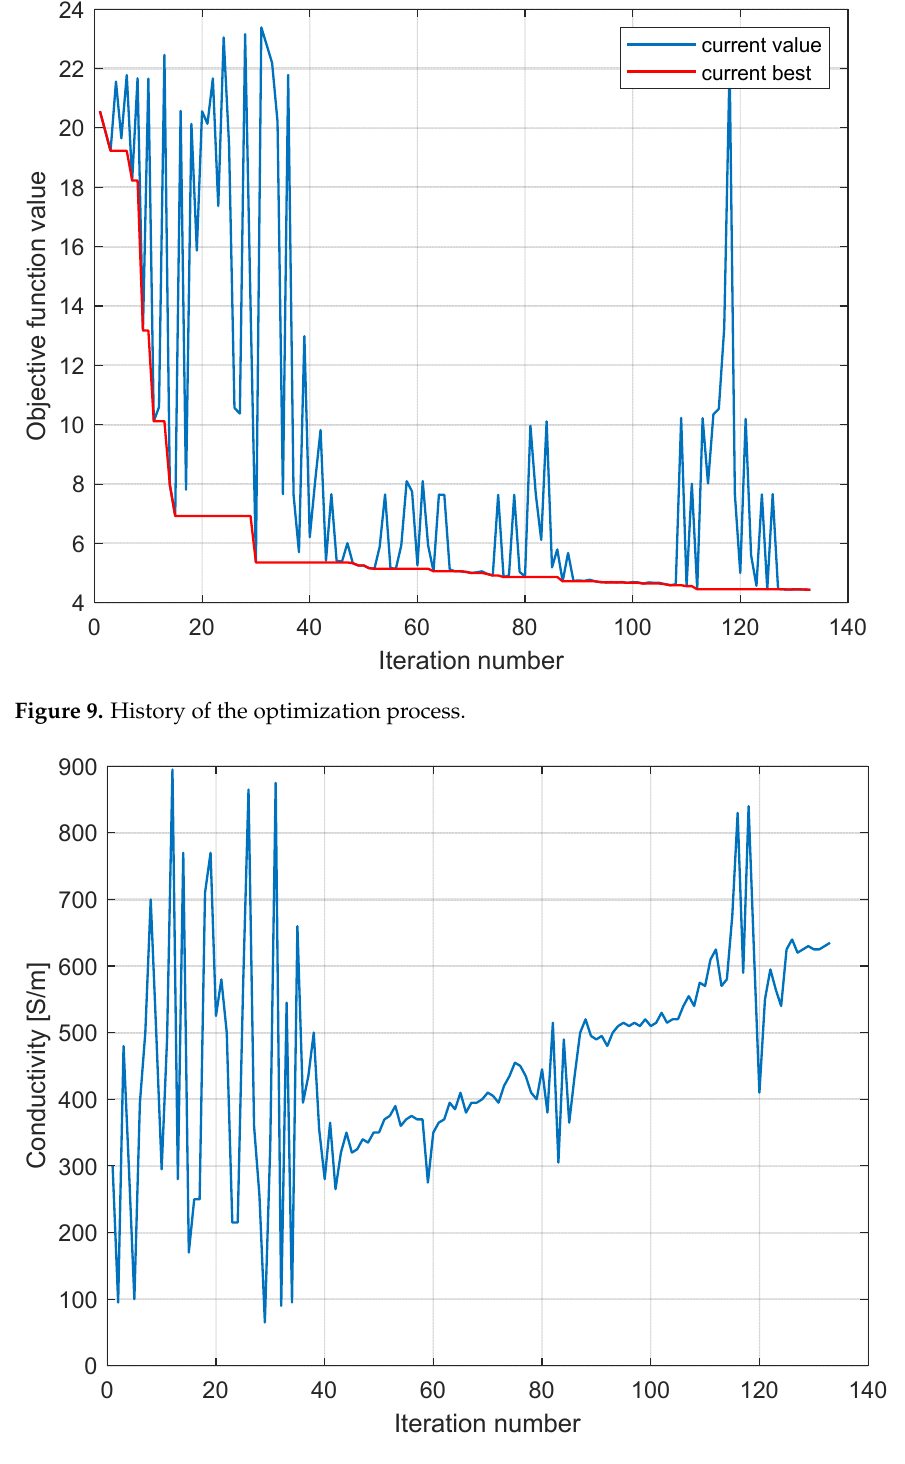
Figure 15. In Figure 16, the power density distribution is presented for the case of a head with a shielding structure that was exposed to horizontal